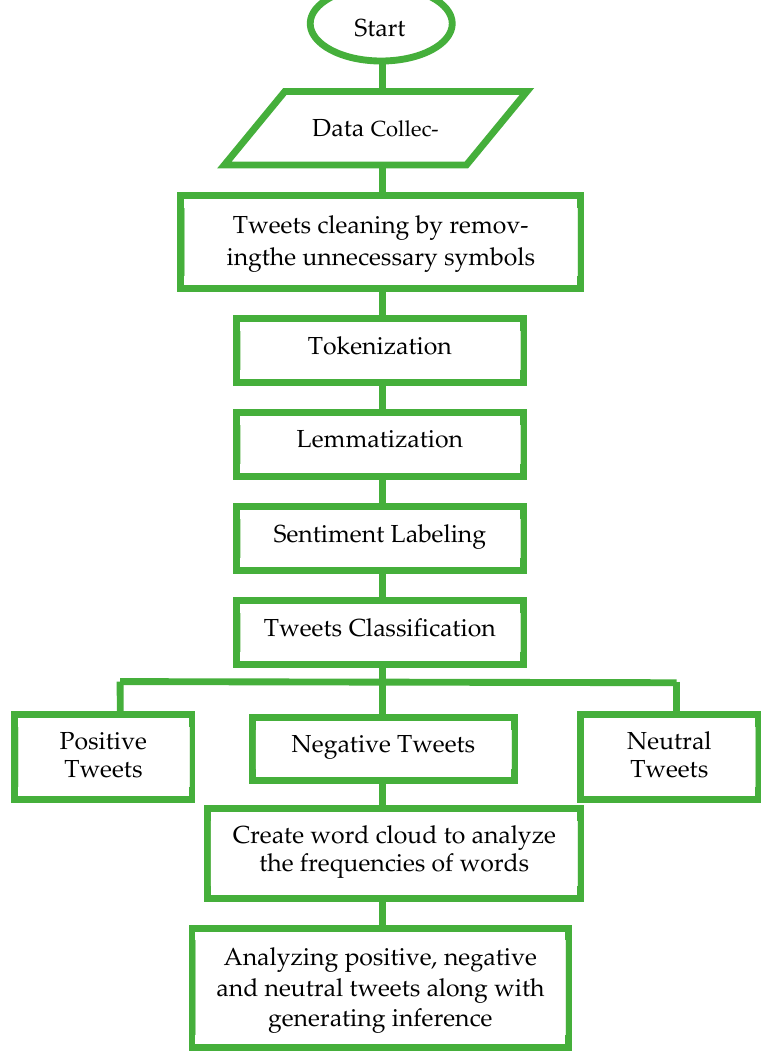
Figure 2. Flowchart: Preprocessing and sentiment